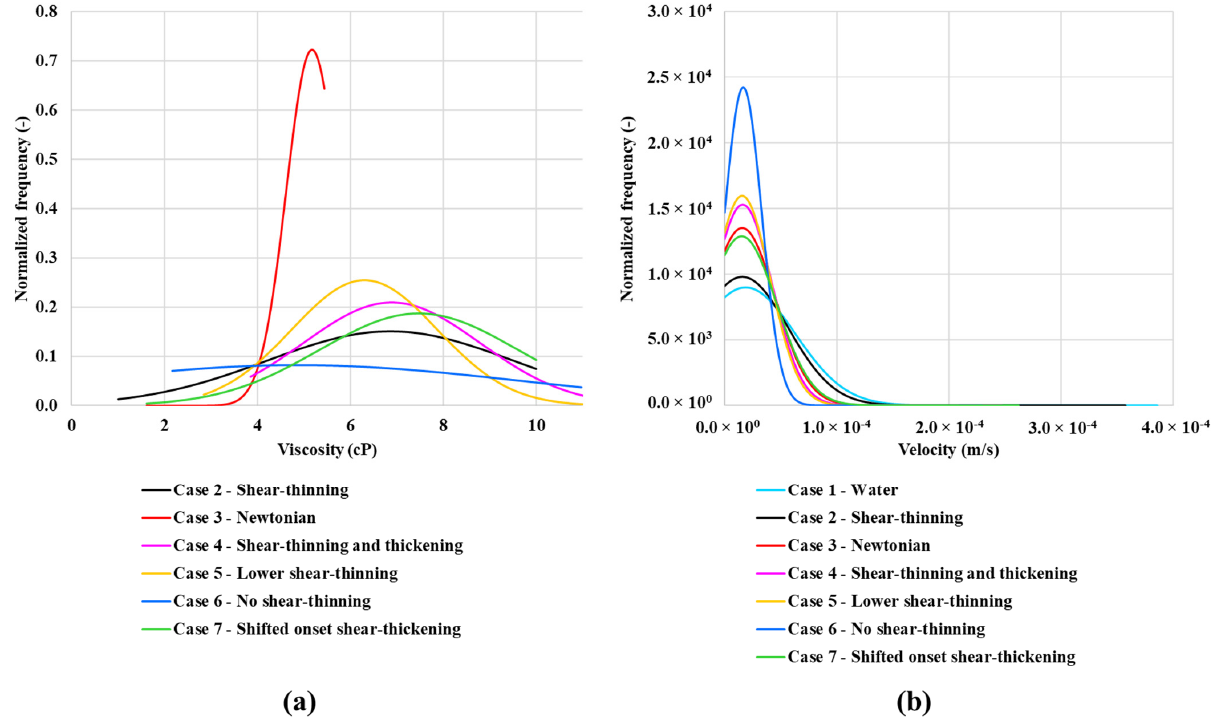
Figure 12. Normalized frequency for in-situ ( a ) viscosity and ( b ) velocity.